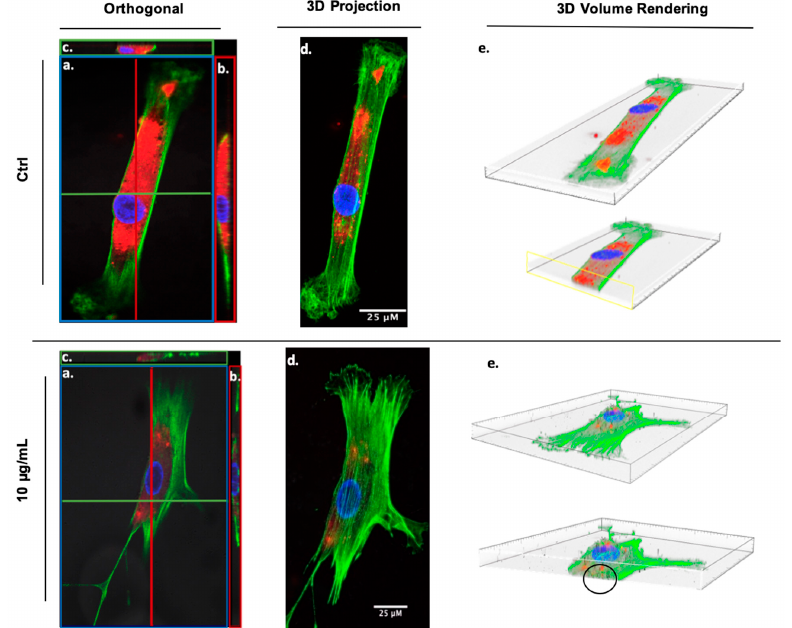
Figure 8. Z-stack images showing nanoMIL-89 uptake in PASMCs. Orthogonal and 3D projections of Z-stack images of pre-stained PASMCs showing: Untreated (control) PASMCs and PASMCs treated with 10µg/mL nanoMIL-89. Projections are: ( a ) Transverse (xz, blue), ( b ) Sagittal (yz, red), ( c ) Frontal (xy, green), ( d ) 3D projection of Z-stake confocal images and ( e ) 3D volume rendering of a single cell with a sliced view showing the cell content. Channels used—Red: CellTrackerTM Red CMTPX Dye, Green: phalloidin, Blue: DAPI, and phase contrast: nanoMIL-89. Images indicate that nanoMIL-89 are internalized within the cytoplasm of the cells (black circle). Scale bar is 25 µm.